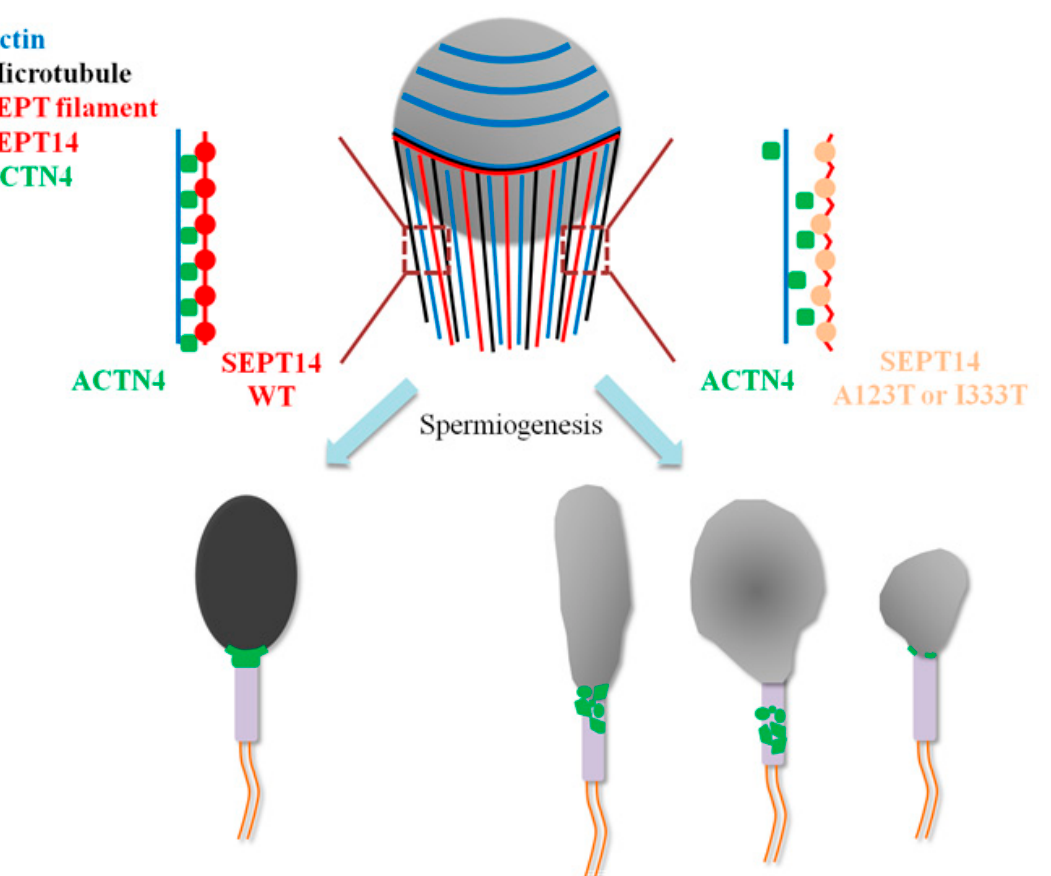
Figure 7. Graphical illustration of the molecular roles of SEPT14, ACTN4, and ACTIN in sperm head formation. During sperm head formation, the manchette structure, which consists primarily of microtubules and actin, assists with sperm head shaping. Filamentous SEPT14 binds to ACTN4/ACTIN complexes, which are involved in sperm head shaping. In sperm with SEPT14 mutations (e.g., A123I or I333T), mutated SEPT14 affects ACTN4-ACTIN function, resulting in abnormal sperm head morphology.